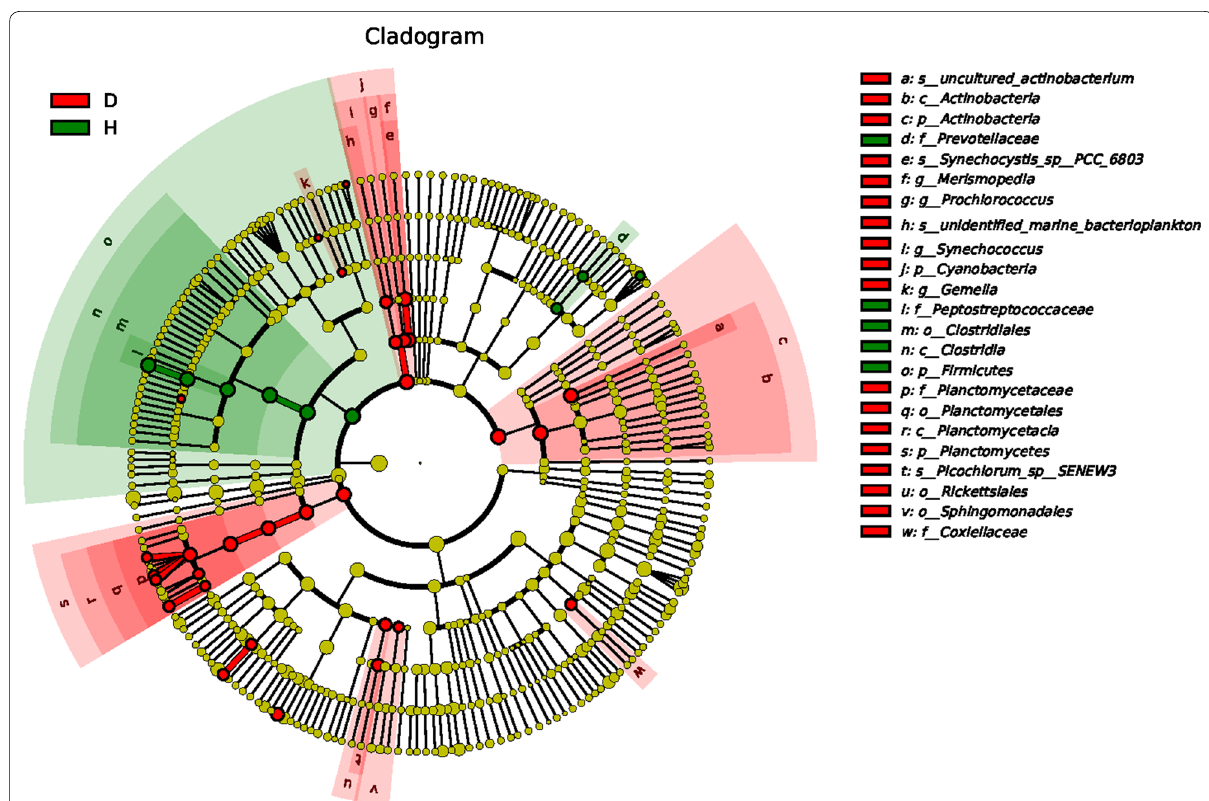
Fig. 4 Cladogram of the intestinal microbiota via LEfSe method identifing the significantly different abundant taxa. The taxa with significantly different abundances among treatments are represented by colored dots, and, from the center outward, they represent the kingdom, phylum, class, order, family, genus, and species level, respectively. The colored shadows represent trends of the significantly differed taxa. Each colored dot has an effect size LDA score as shown in Fig.